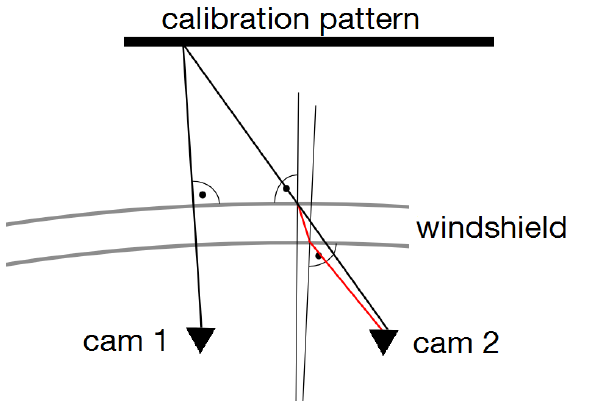
Figure 6. Schematic top down view: Image rays (black lines) of a calibration mark intersecting the windshield. If intersection is not orthogonal to windshield, the image ray is fractured (red line).